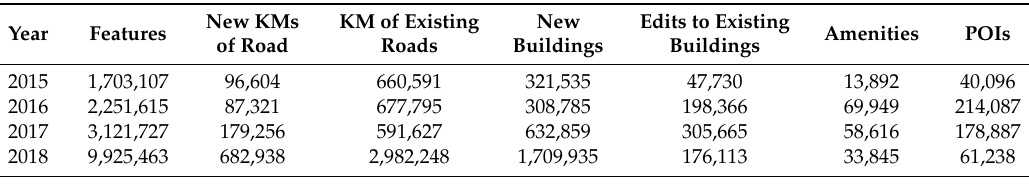
Table 2. Total number of features, kilometers of roads, number of buildings, amenities, and points of interest edited per year by all corporate editors. The increase in number of features edited since 2015 shows the overall rise in corporate editing.